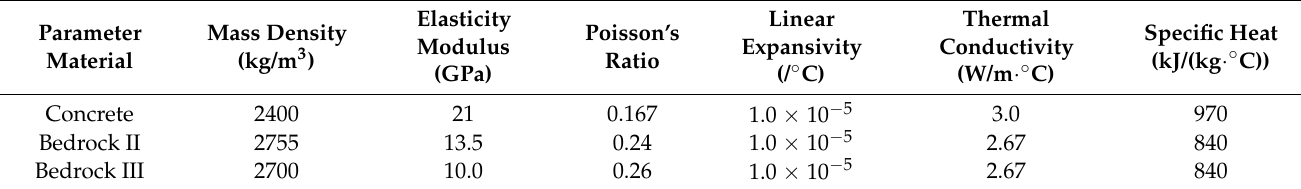
Table 1. Material